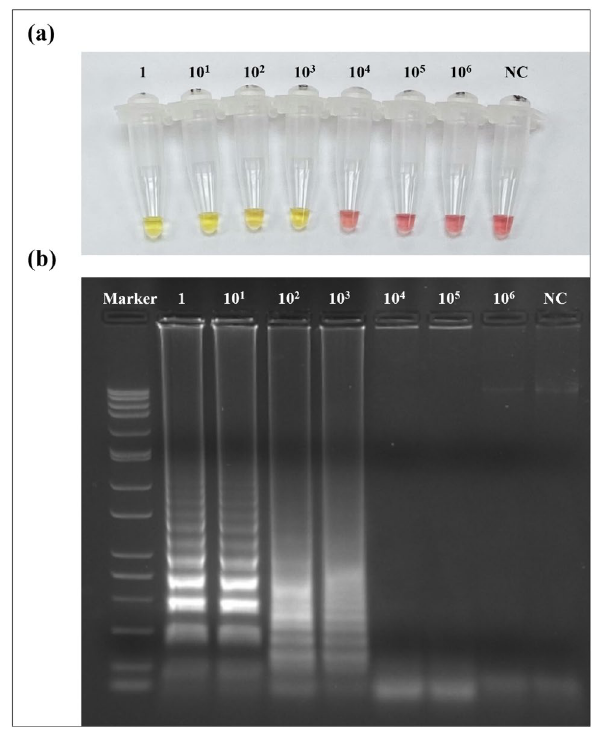
Figure 4. The limit of detection (LoD) of E gene primers tested in the colorimetric RT-LAMP assay on serially diluted SARS-CoV-2 synthetic RNA control ( a ). The assay detected up to 10 3 dilutions corresponding to 500 copies/reaction volume (25 µL) or 20 copies/µL. ( b ) Validation of the colorimetric LoD results via loading the RT-LAMP product post-reaction in 2% agarose gel showing band patterns of the detected diluted samples.